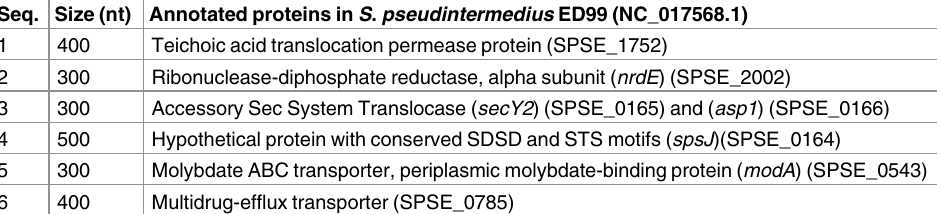
Table 2. S . pseudintermedius -specific sequences and annotations in strain ED99 that resulted from the sliding-frame